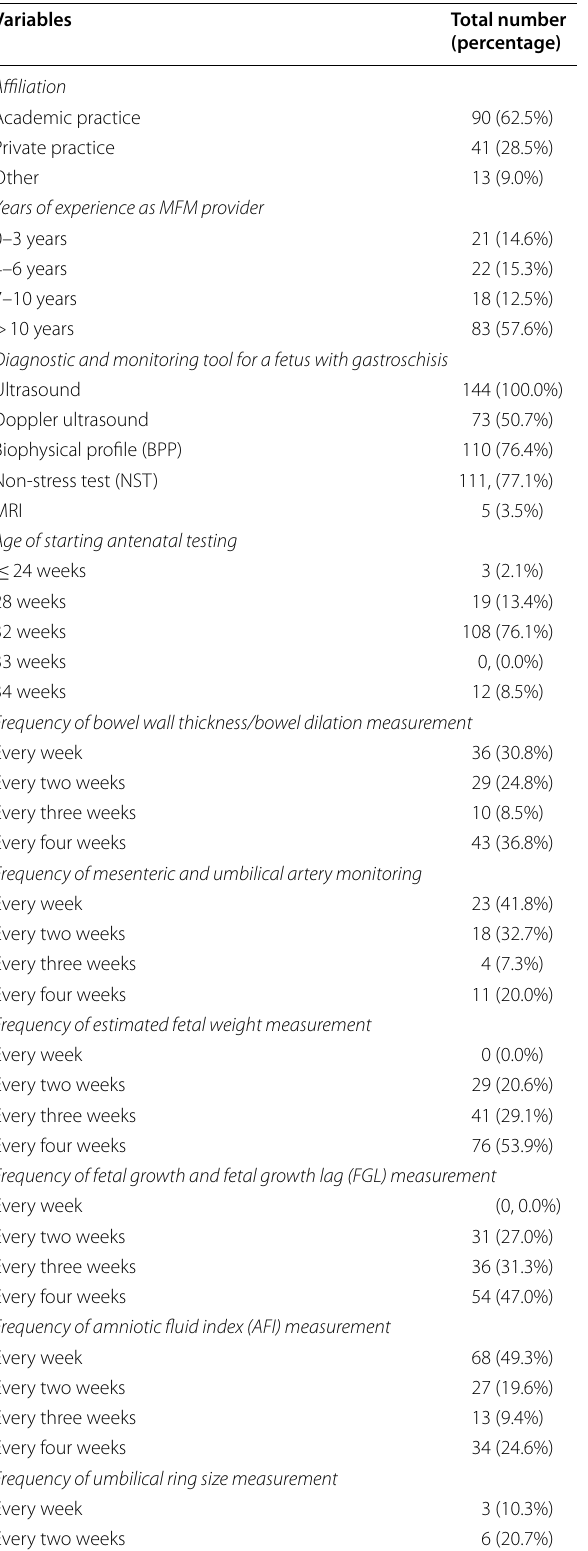
Table 1 Demographic and responses of the entire